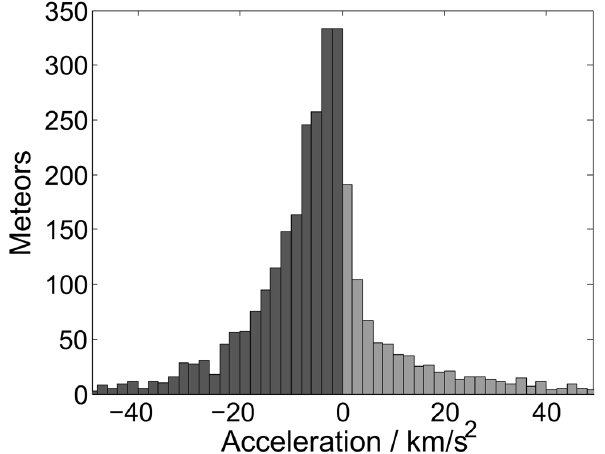
Fig. 12. Histogram of the observed meteor accelerations; the light grey part (positive accelerations) is ignored for further calculations.